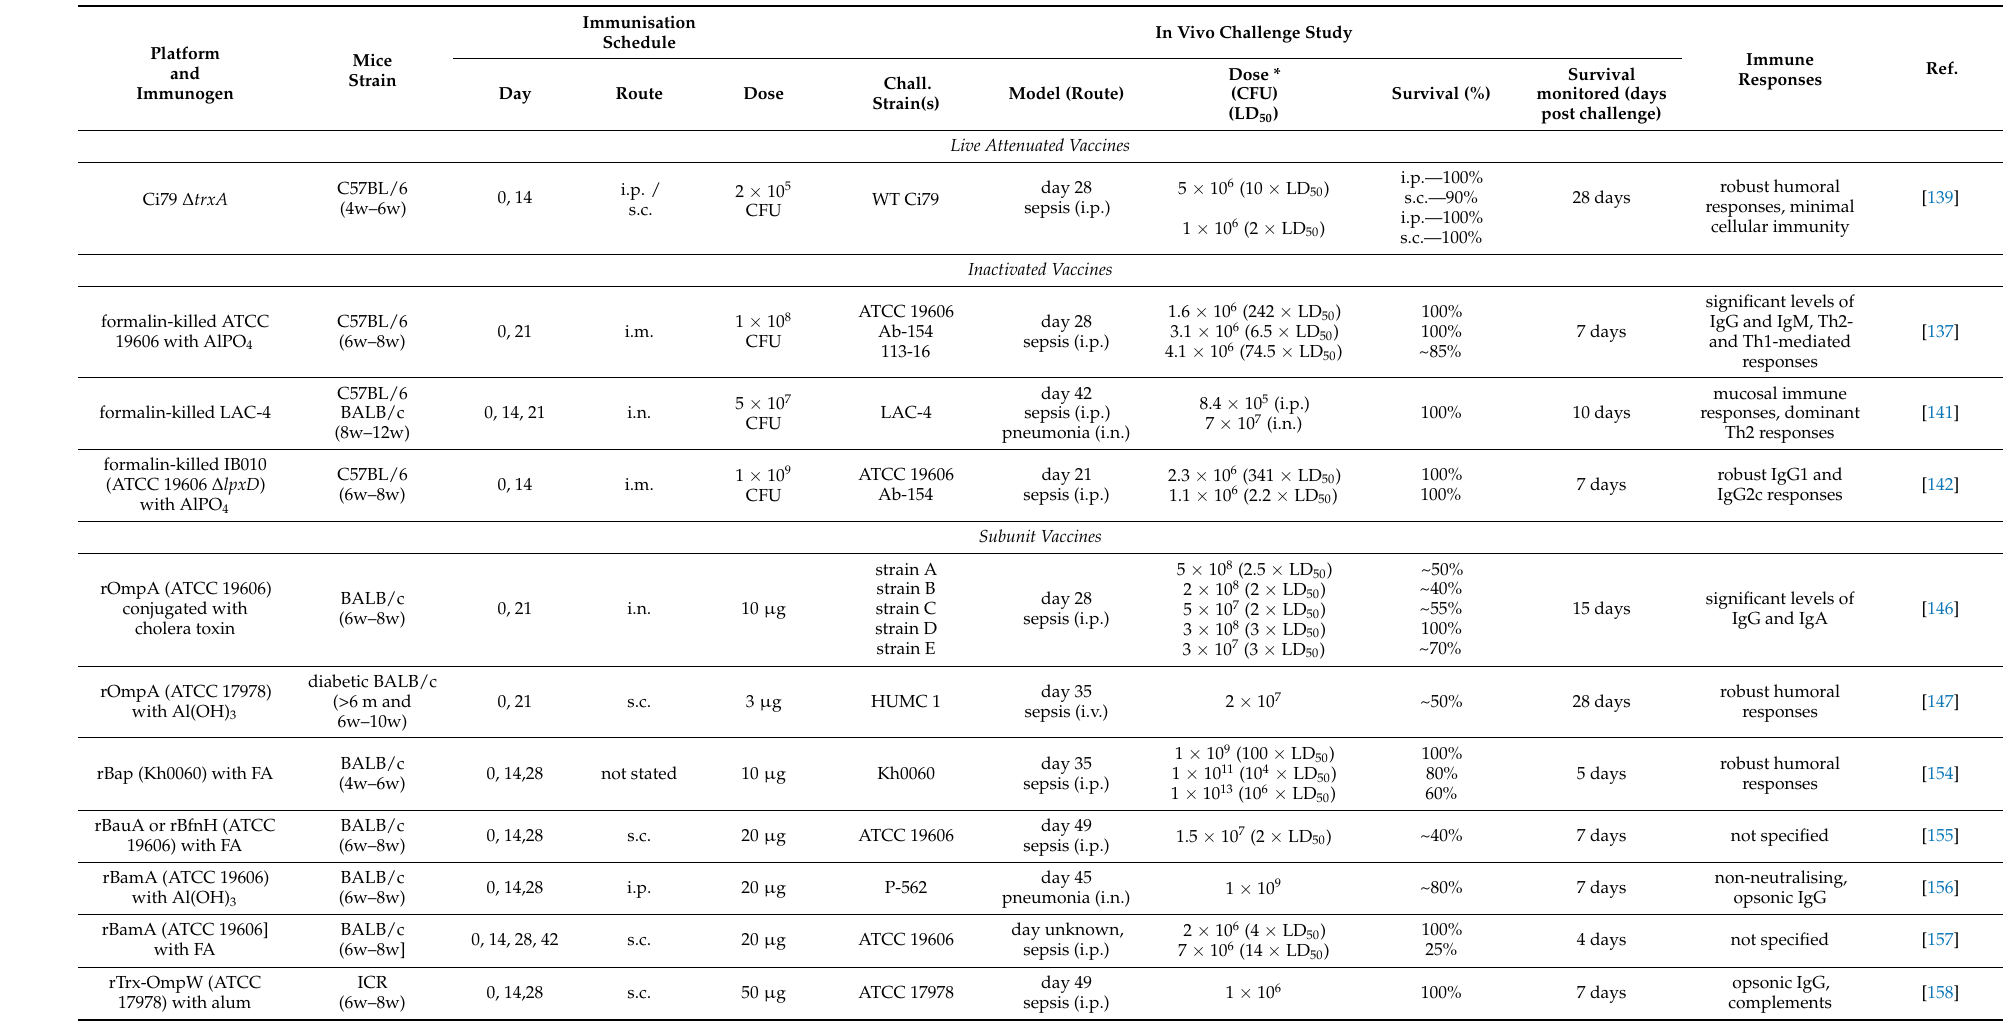
Table 3. Preclinical active immunisation studies of A. baumannii vaccine